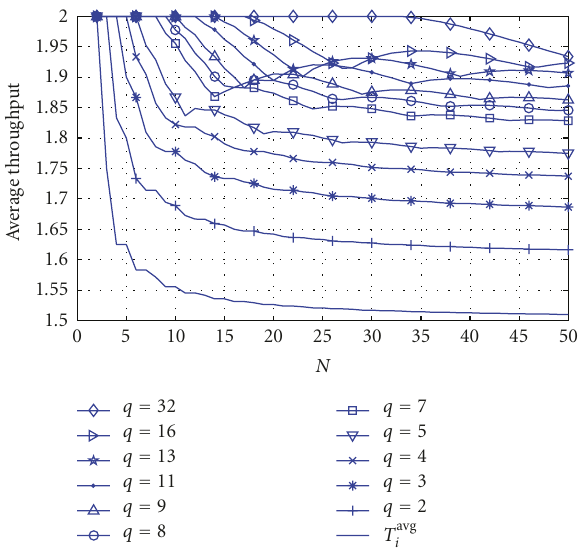
Figure 1: Average linear network coding